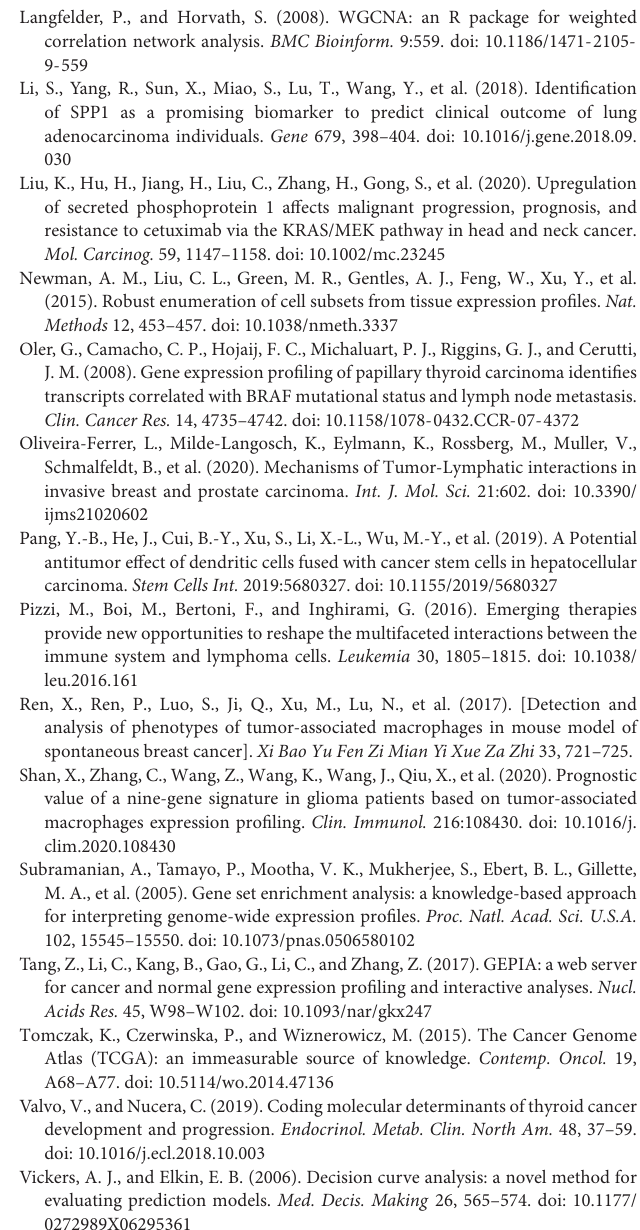
Supplementary Figure S1 | Sample clustering (Discovery cohort). Sample dendrogram and trait heatmap. On the heatmap, red represents a higher percentage of immune cell infiltration. Supplementary Table S1 | Clinical features of the thyroid cancer samples in each cohort. P A : Comparison of validation cohort A and the discovery cohort. P B : Comparison of validation cohort A and the discovery cohort. Supplementary Table S2 | Univariate cox analysis within the hub module. Supplementary Table S3 | Univariate and multivariate Cox analyses of the clinical features in the entire cohort. Supplementary Table S4 | GSEA